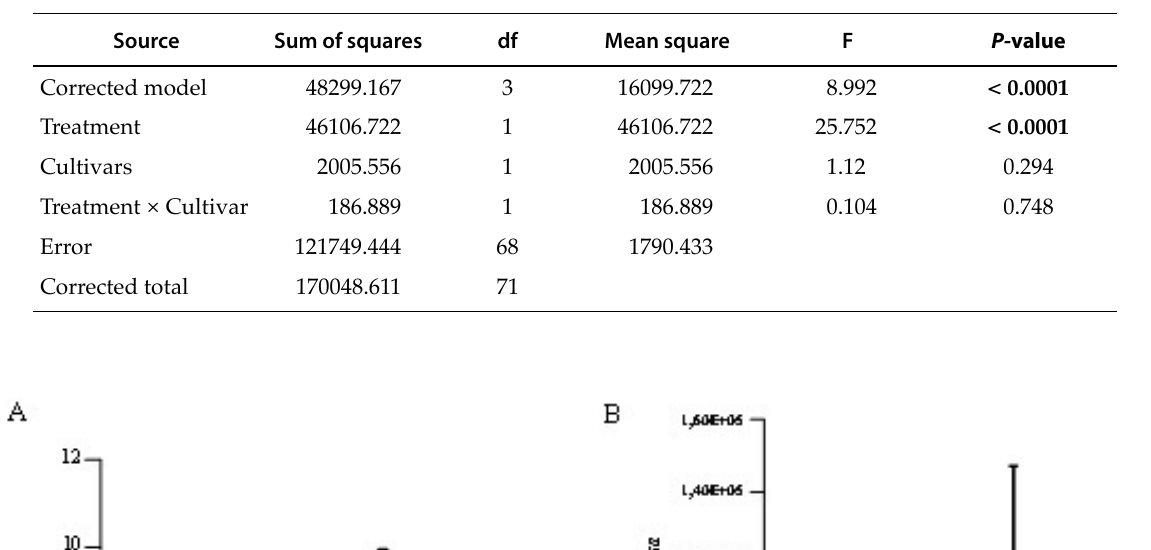
Table 1. Two-way ANOVA results considering two factors (treatment and cultivar, and their interactions) for monthly mean values as obtained from the experimental blocks in Veglie (LE). The analysis shows a very significant effect of treat - ment and a not significant effect of cultivar and interaction treatment ×